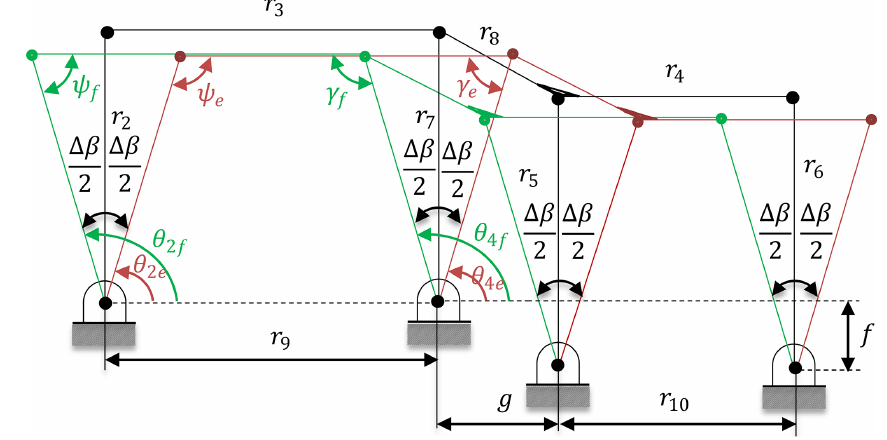
Figure 8. Four-bar mechanism in three positions (forward-undeflected-fully withdrawn) with design parameters.